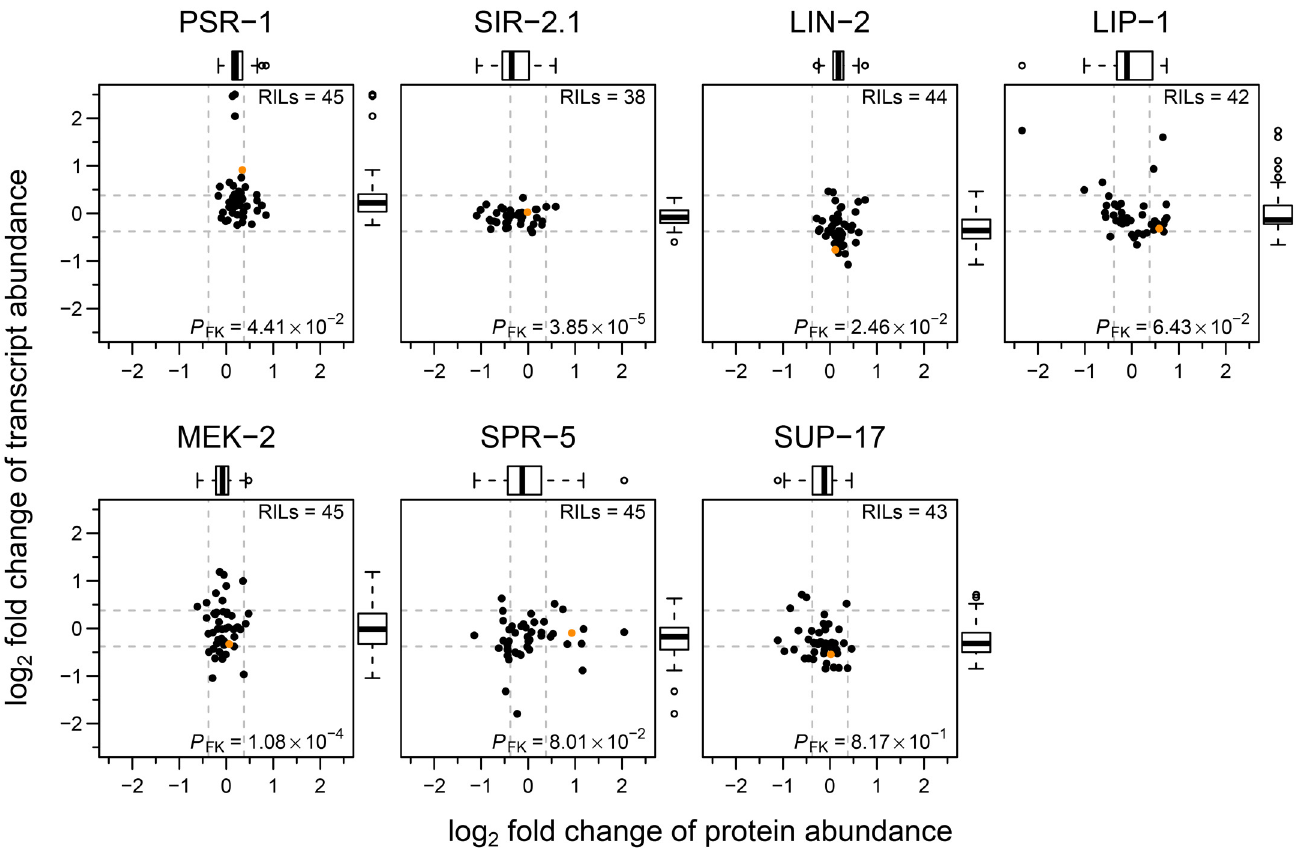
Fig 6. Protein and transcript abundance variation of the signalling pathway proteins used in pQTL mapping in CB4856 and 45 RILs. Comparison of protein and transcript abundance (log 2 scaled fold changes relative to N2) in CB4856 (solid orange circle) and RILs for the seven proteins used in pQTL mapping. Horizontal and vertical dashed lines represent the fold change cut-off of 1.3 (~ 0.38 on log 2 scale). Tukey-style box plot on top and right side represents variability in protein and transcript log 2 fold changes respectively. P -value from Fligner-Killeen test for homogeneity of variances between protein and transcript data is denoted by P FK